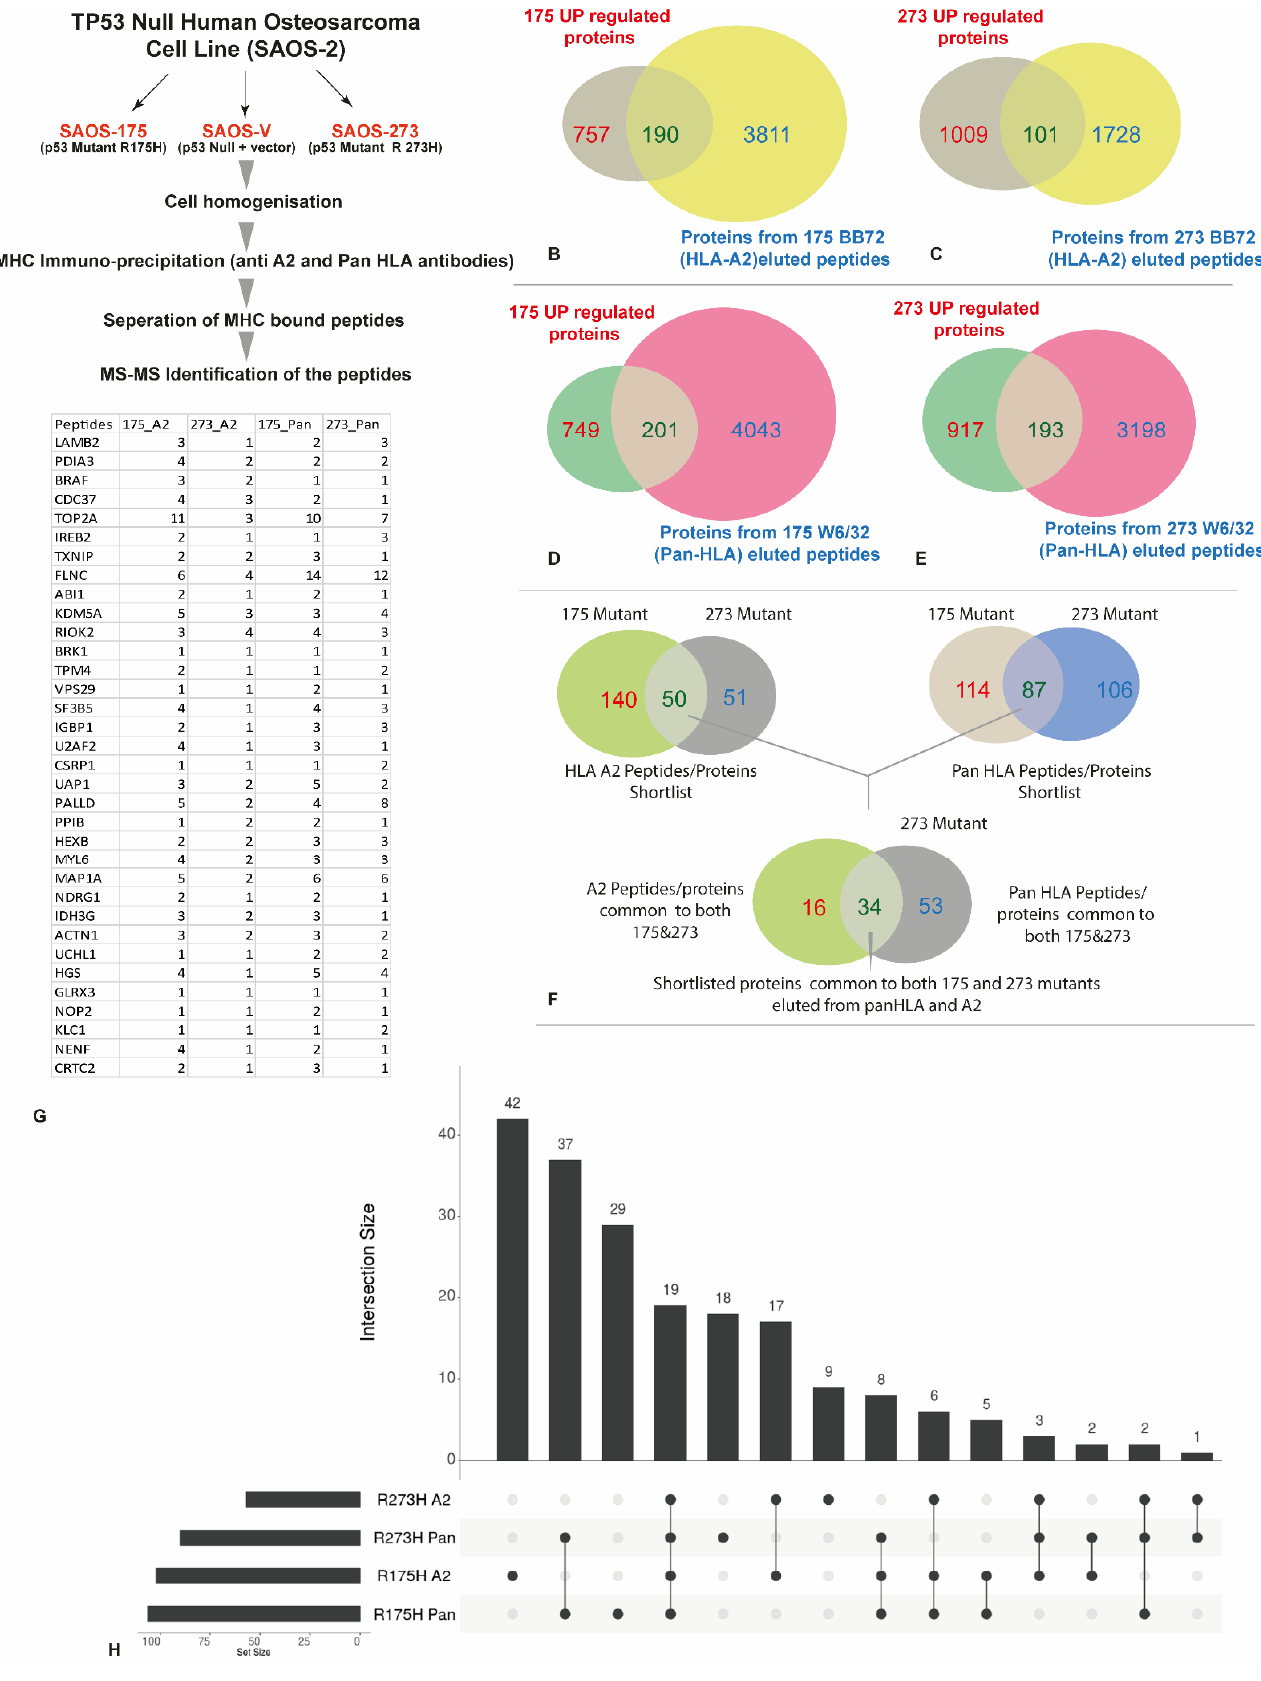
Figure 3. Immunopeptidome profiling of two TP53 mutants revealed distinct HLA-A2 and